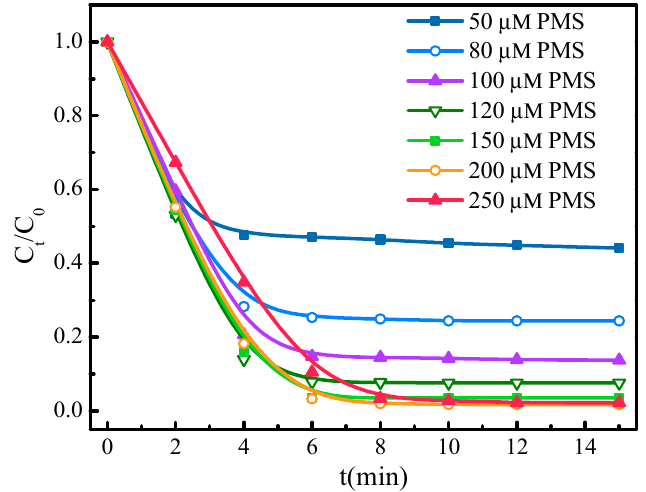
Figure 4. The effects of the PMS dosage on the decolorization of Orange ([Fe 3+ ] 0 = 100 µM [Orange II] 0 = 50 µM, [oxalate] 0 = 80 µM, under UVA irradiation, λ irr. = 365 nm, pH 3).